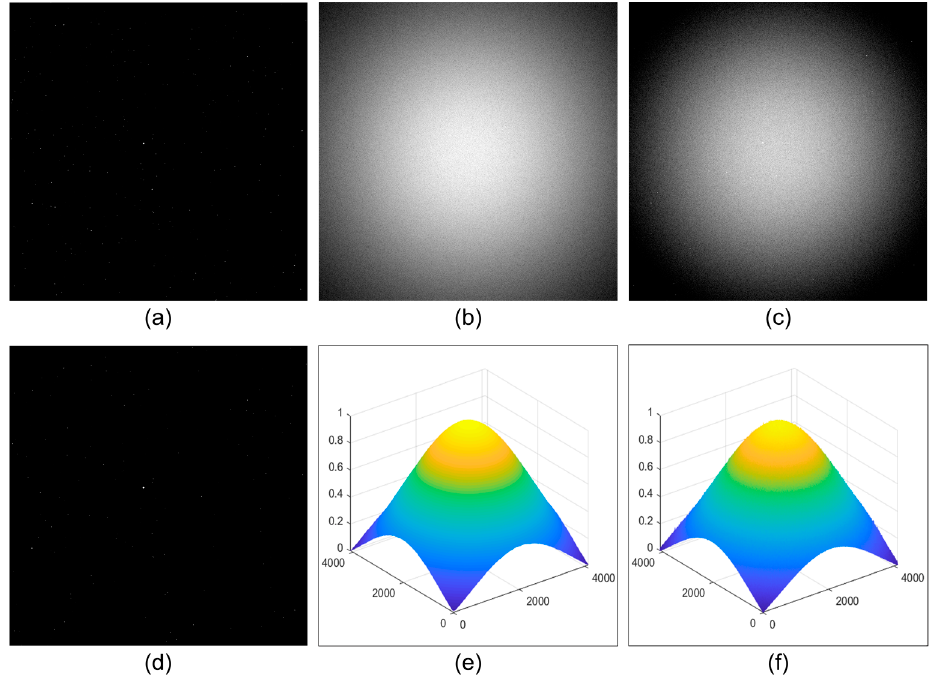
Figure 3. An example of correcting a simulated image with our method. ( a ) The ground truth image; ( b ) the simulated inhomogeneous background; ( c ) the simulated image by compositing the ground truth and the simulated background; ( d ) the clear image after the correction; ( e ) the grey-level distribution of ( b ); and ( f ) the estimated background by our method.